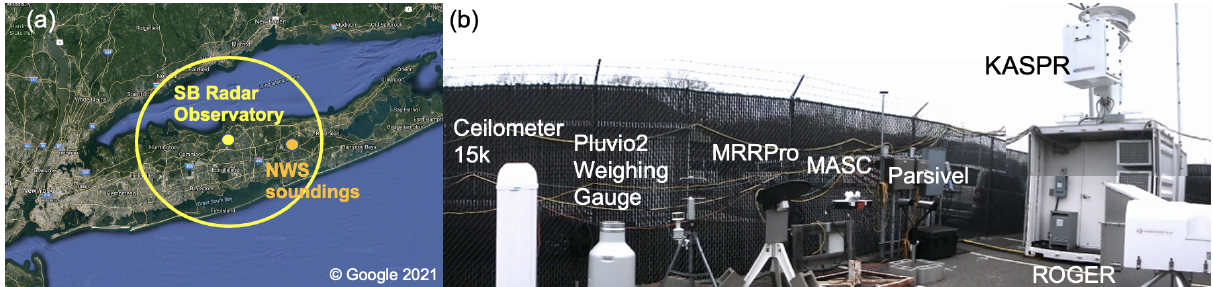
Figure 3. (a) Location of the Stony Brook Radar Observatory. (b) Instruments deployed at SBRO. The big yellow circle in (a) represents the KASPR 30km observation